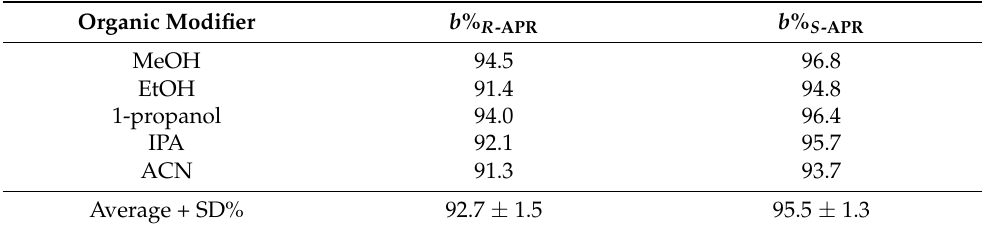
Table 3. Bound percentage values ( b %) determined for the extrapolation to zero percentages of different organic